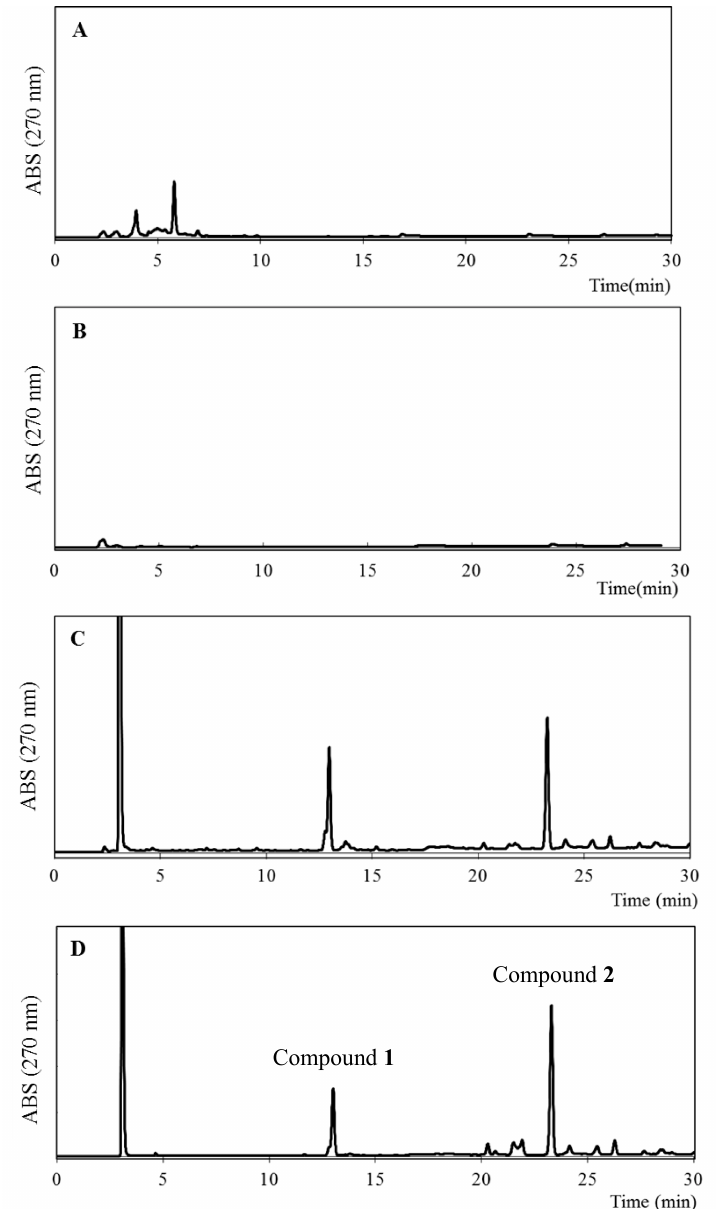
Figure 7. HPLC profiles of ethanol extracts of I. viscosa ( A ), J. phoenicea ( B ), F. communis ( C ), and EEAP1 ( D ).